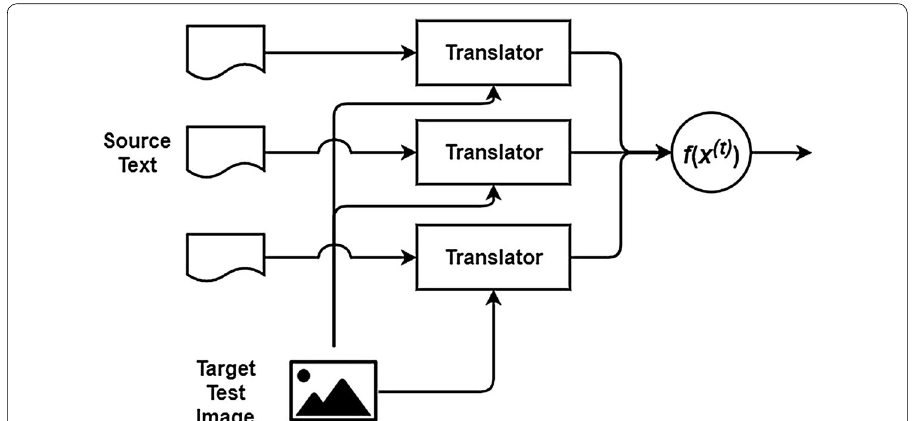
Fig. 3 Illustration for TTI adapted from [36] showing the process of semantic label propagation from source texts to test image using the learned translator. Output is a final prediction